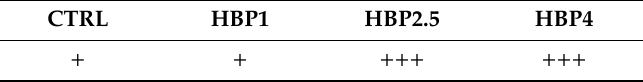
Figure 3. Immunohistochemical detection of TNF- α in medium intestine of the different experimental groups ( a–d ). High magnification images showing TNF- α + cells (white circle) in the submucosa and in the lamina propria of intestine from HBP2.5 ( e ) and HBP4 ( f ) groups. Positive reactions are shown in green. Nuclei were stained with DAPI (blue). Scale bar: a,b,c,d = 50 µm; e,f = 20 µm. Table 8. Relative density of TNF- α + cells in medium intestine.